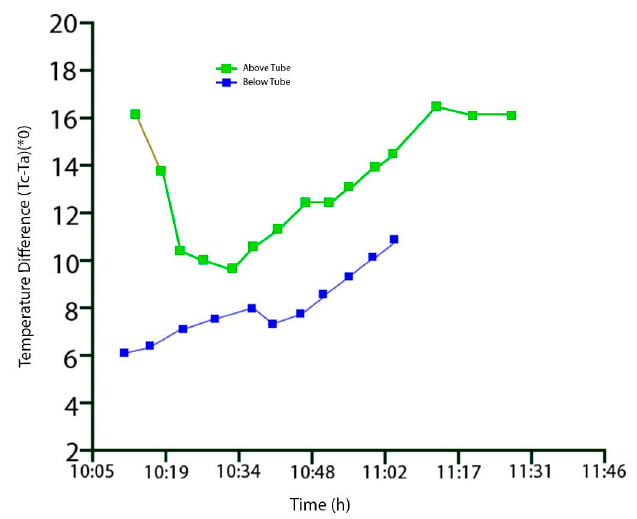
Figure 9. Changes in the temperature difference (Te–Ta) over time.